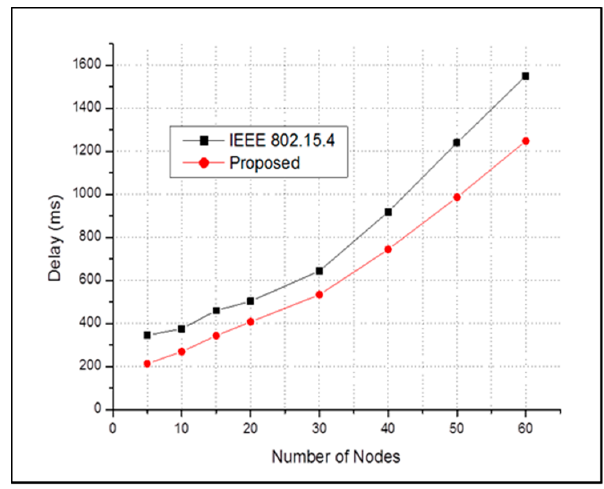
Figure 8. End-to-end average packet delay of all sensor nodes in case of NO emergency event.